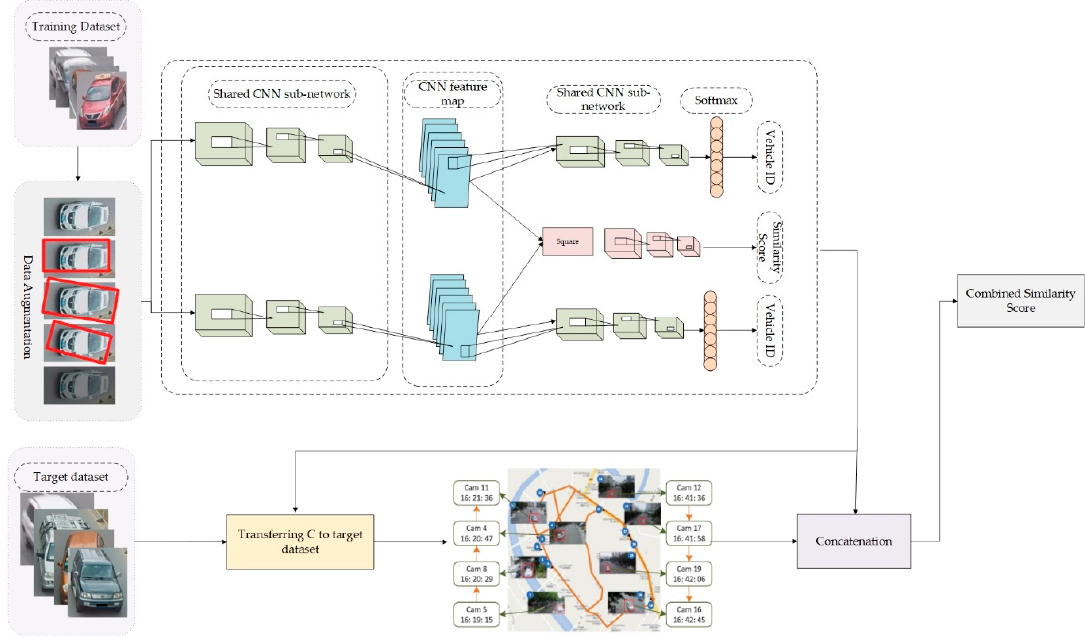
Figure 3. The proposed framework for cross ‐ dataset vehicle Re ‐ Id.